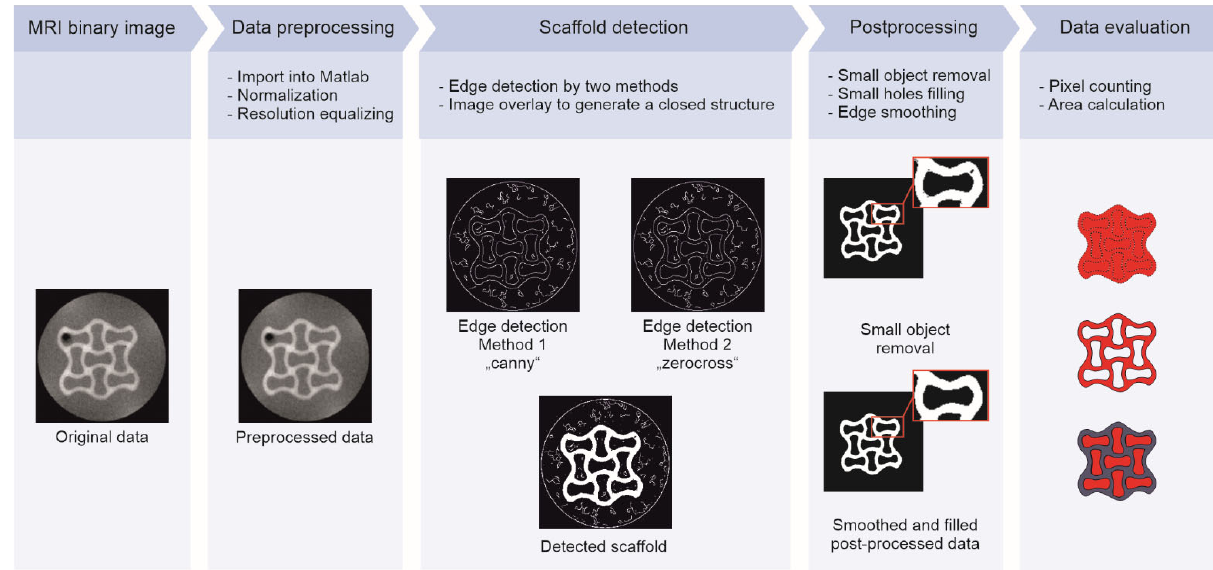
Figure 1. Overview of the image processing. After import into MATLAB ® , raw image files were preprocessed by normalization and resolution equalization. The scaffold was detected for the fifth slice in the z ‐ direction in each data set, whereas small objects were removed during image postpro ‐ cessing. Scaffold defects were filled and edges smoothed to determine the hydrogel lattice and in ‐ terstitial area in the measured slice.